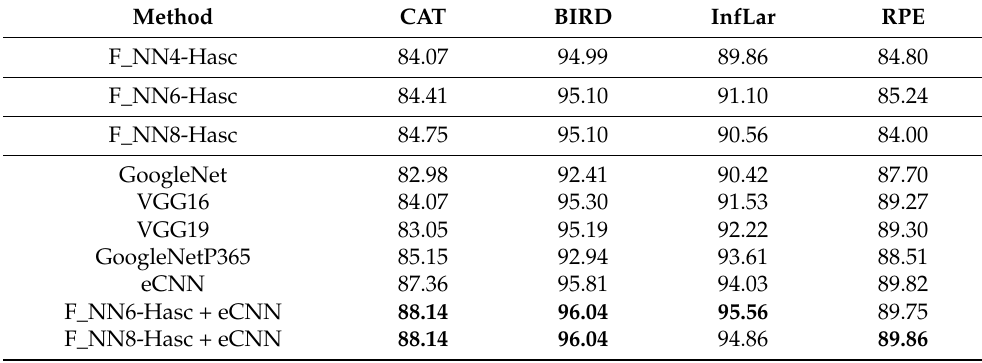
Table 4. Performance accuracy obtained considering different standard CNN. Best values are in bold-faced.